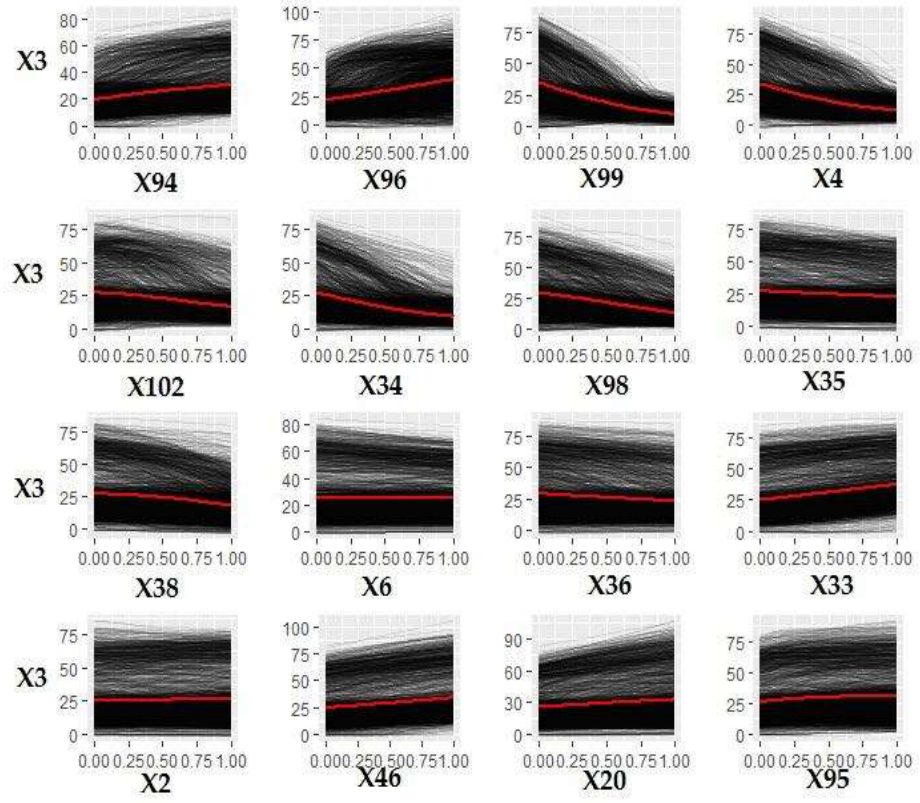
Figure 8. ICE curves of the 16 variables most influencing percentage of separate waste collection (X3)*; *X20 and X95 have the same percentage of influence.